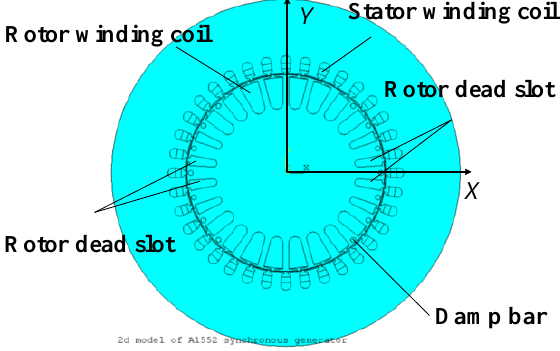
Figure 8. Finite element model of the generator.